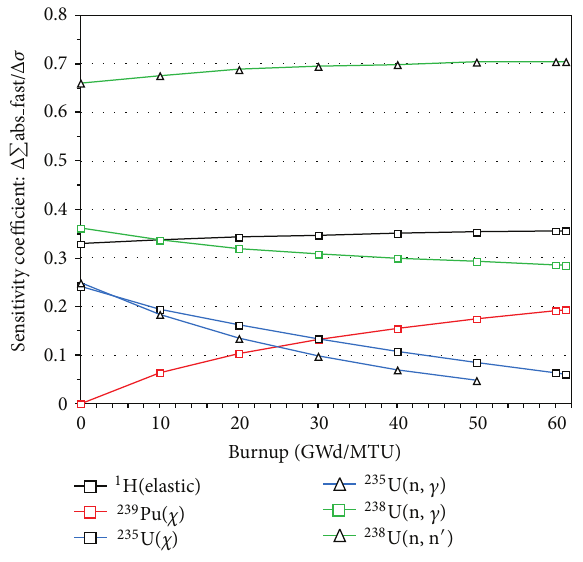
F 7: Sensitivity coefficients calculated with SCALE6.1/TRI- TON/TSUNAMI.